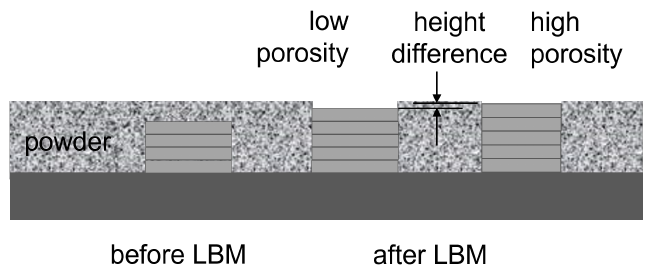
Figure 11. Schematic representation of the height change of structures due to laser beam melting. From left to right: An already existing structure is covered with metal powder ready for the next process step. The volume of the initial powder shrinks due to the processing. Therefore, the height of the recrystallized structure is lower than that of the surrounding powder bed surface. The shrinkage of the volume due to the melting process depends on the fraction of pores included in the treated material. Therefore, during growth of the structure, a small height difference evolves due to the density dependence of the volume of recrystallized